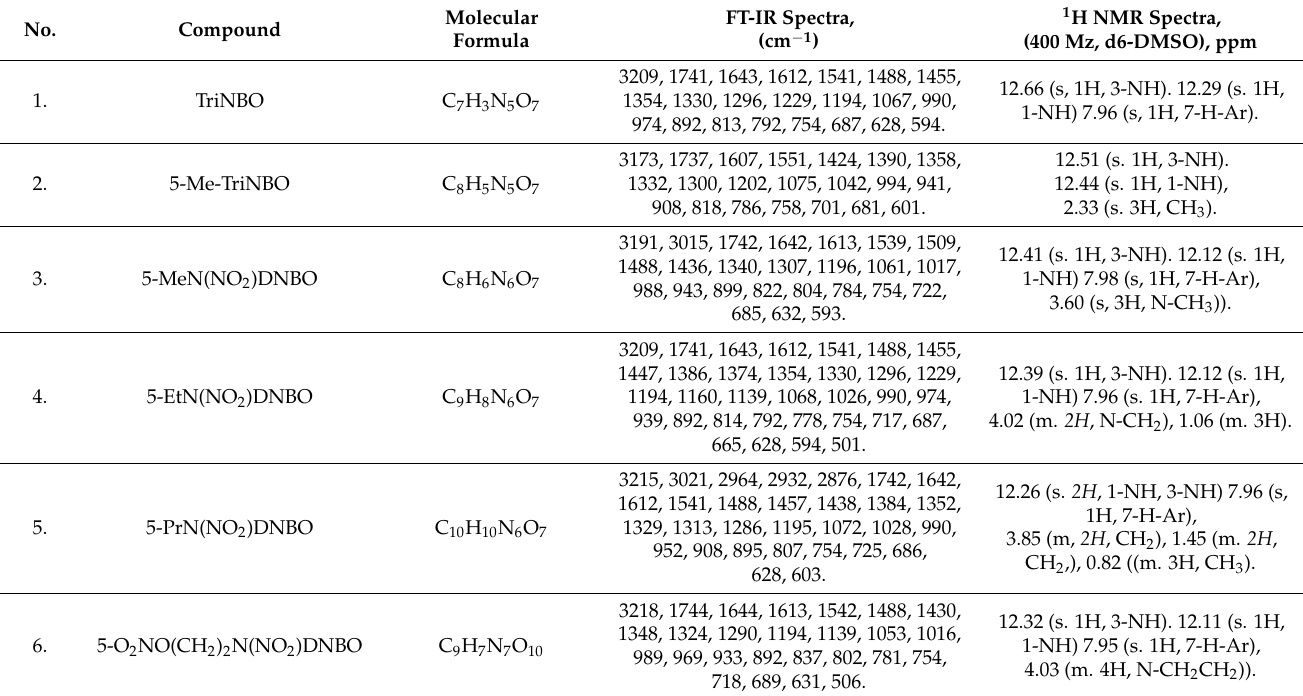
Table A2. Spectral data of synthesized 1,3-dihydro- 2H -benzimidazol-2-one